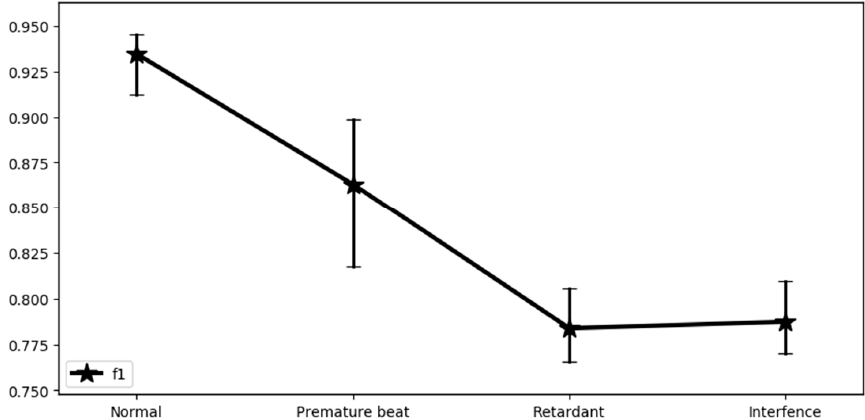
Figure 7. Fivefold cross-validation results.